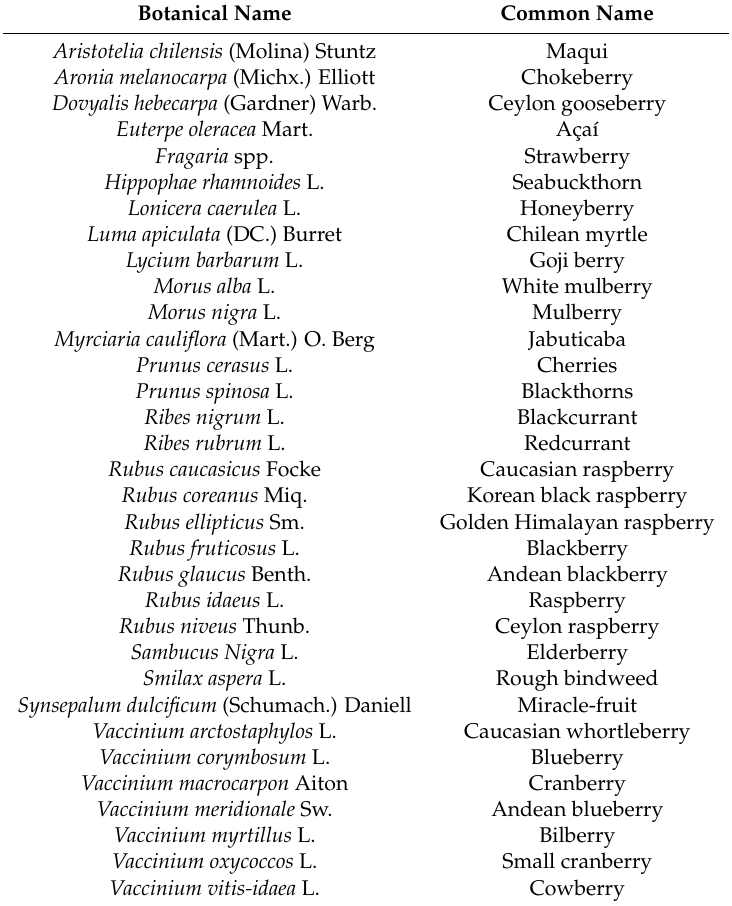
Table A1. Botanical and common name of red fruits named through the